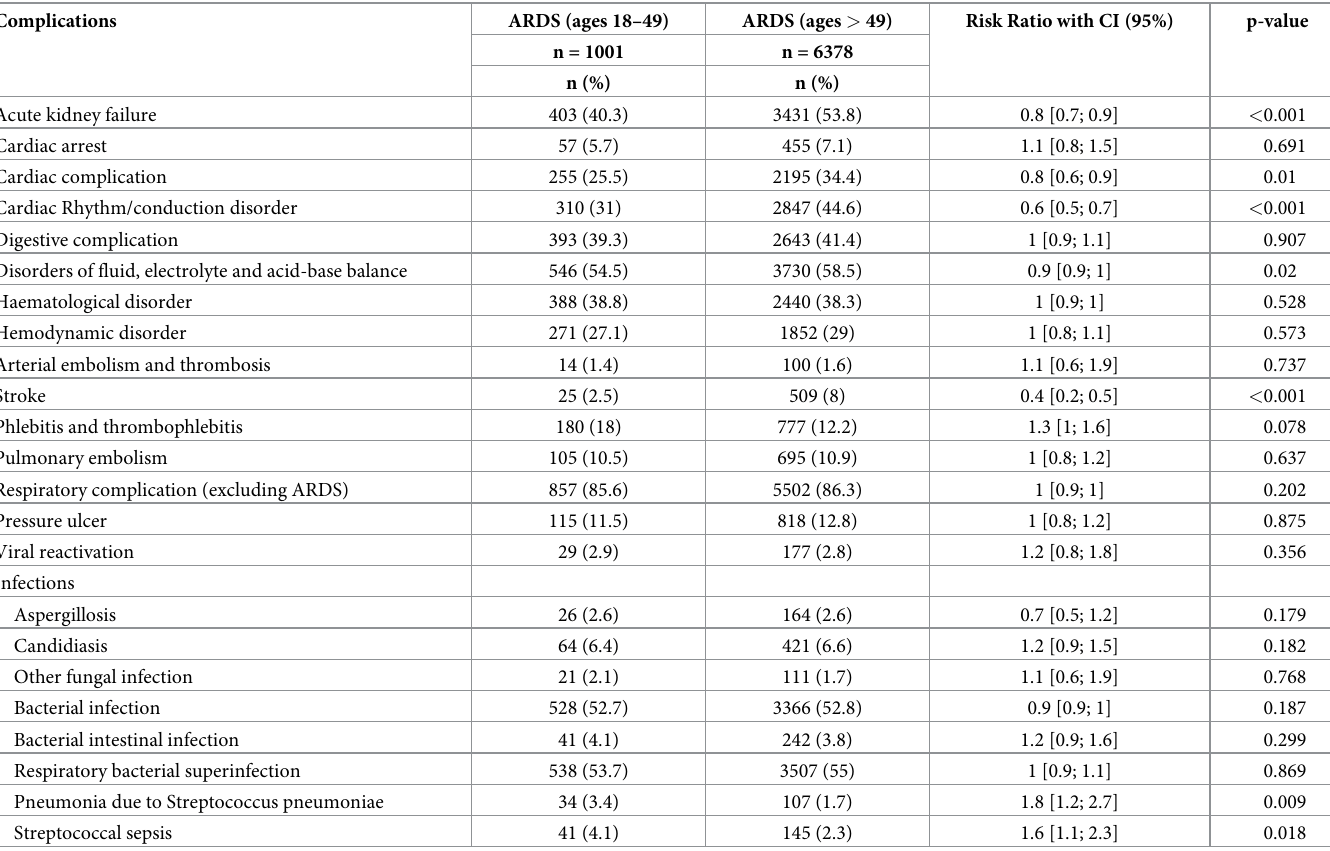
Table 3. Proportion and associated risk ratio of complication classes for the young compared to old adult with